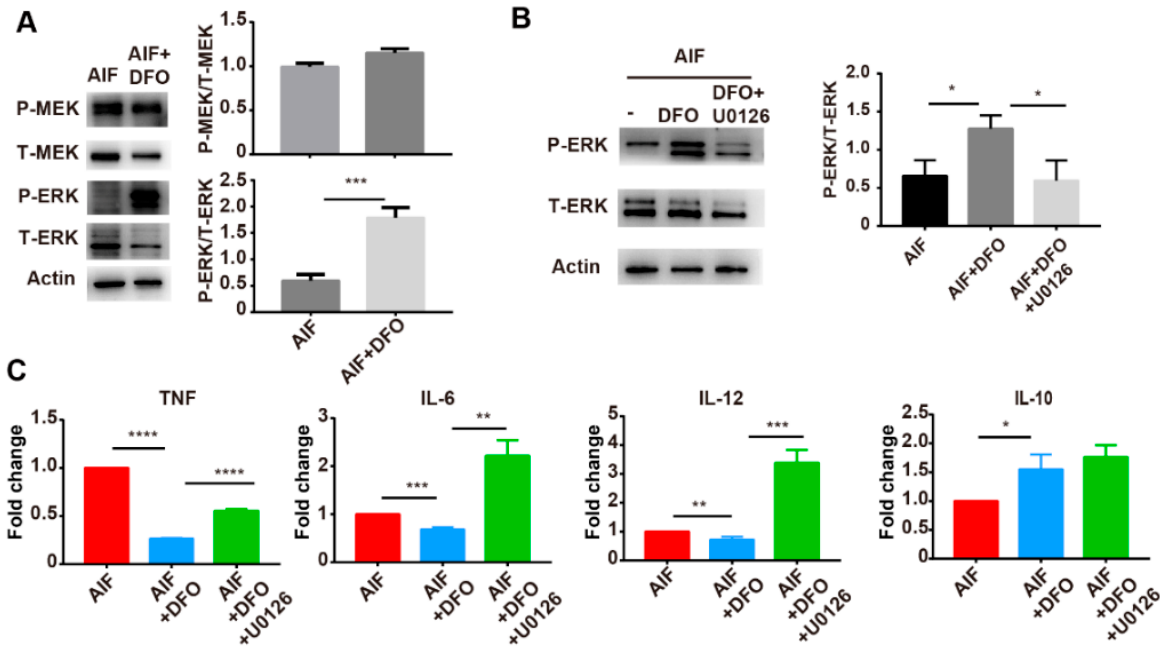
Figure 5. Iron promoted M1 polarization of macrophages by inhibiting the phosphorylation of ERK. ( A ) RAW264.7 cells were treated with AIF with or without DFO treatment for 24 h, the MEK/ERK pathway was analyzed by western blot. ( B ) Cells were pretreated with U0126, an inhibitor of MEK/ERK pathway, for 30 min to inhibit the phosphorylation of ERK. The phosphorylation of ERK was analyzed by Western blot and ( C ) the expression levels of TNF , IL-6 , IL-12 and IL-10 were measured by Real-Time qPCR. Experiments were performed in duplicate. * p < 0.05, ** p < 0.01, *** p < 0.001, **** p < 0.0001.